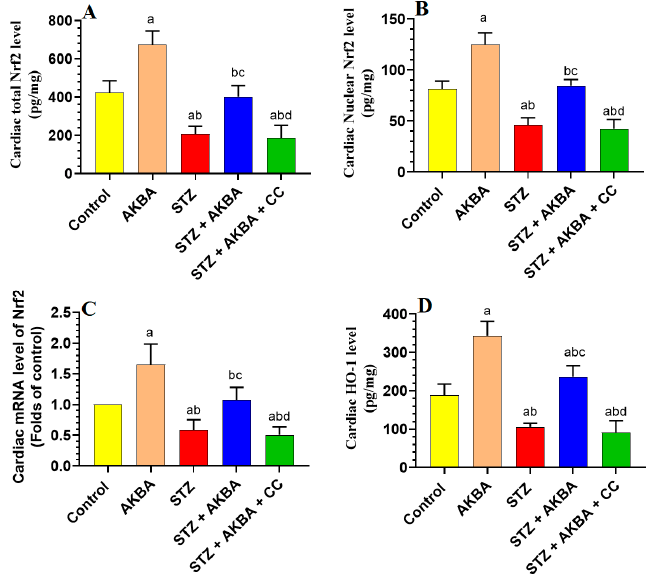
Figure 5. Total, nuclear, and mRNA levels of Nrf2 ( A – C ), and levels of heme oxygenase-1 (HO-1) ( D ) in the left ventricles (LVs) of all rat groups. Data were analyzed with one-way ANOVA followed by Tukey’s test. Values are presented as mean ± SD (n = 8/group). Data were considered significantly different at p < 0.5. a: significantly different as compared to control rats; b: significantly different as compared to AKBA-treated rats; c: significantly different as compared to STZ-diabetic rats; d: significantly different as compared to STZ + AKBA-treated rats. CC–compound C (selective AMPK inhibitor).